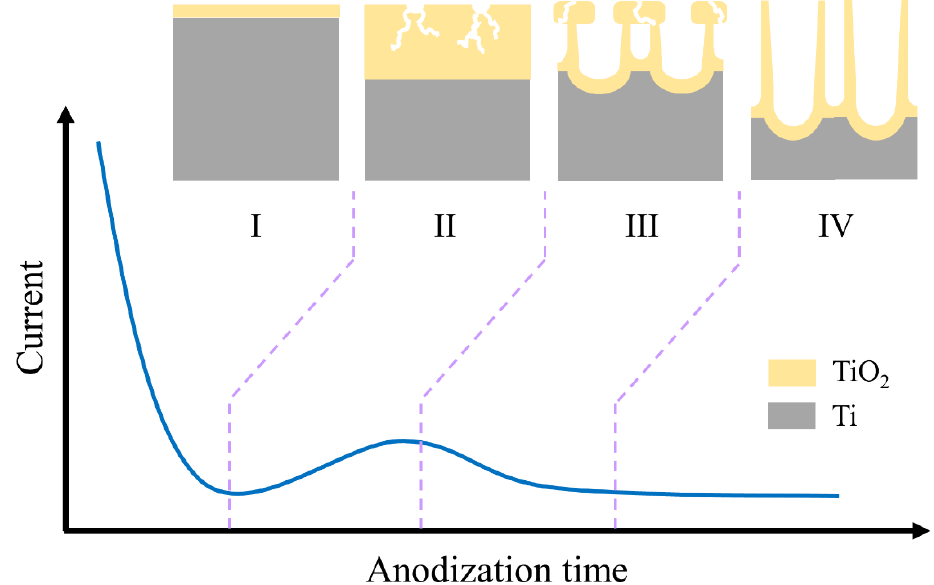
Figure 2. A representative current–time curve for the formation of tubular structures. (I) The current decreases drastically due to the growth of the barrier oxide during initial stage of anodization. Next, (II) nano-pits or cracks caused by F − ions cause an increase in the current due to the concentrated electric fields on these pits. Once the tubular structure has formed and is growing evenly, the current declines and converges at a stable value due to the increased diffusion length of the ions involved in the reaction. Reproduced with permission from ref [11]. Friedrich-Alexander-Universität Erlangen- Nürnberg (2013).